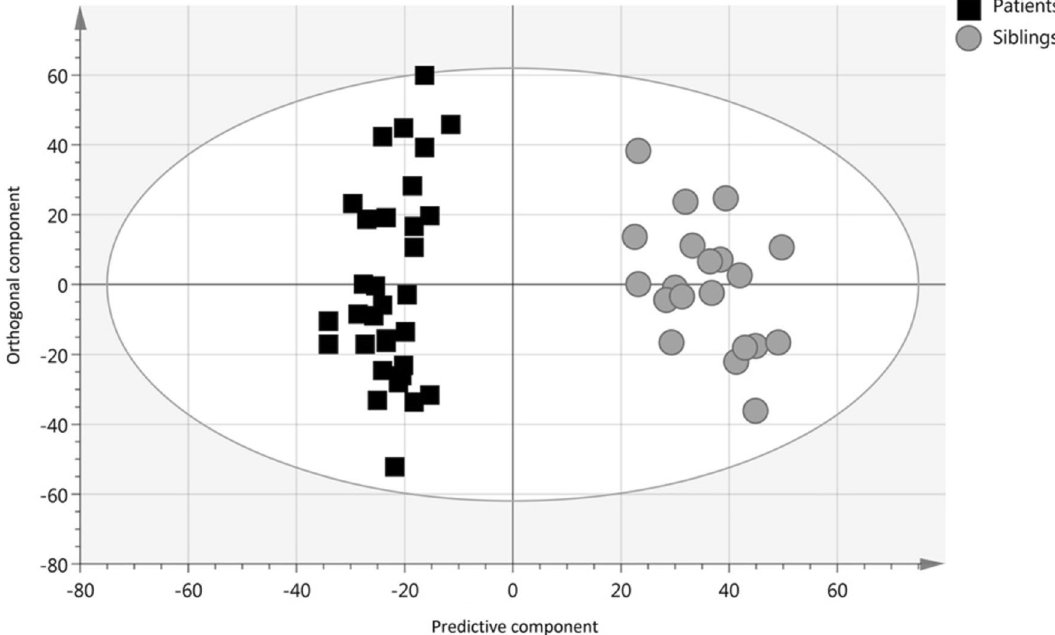
Figure 2. Fecal metabolome OPLS-DA scatter plot of HD patients (n = 34) vs. healthy siblings (n = 21). The validity of the OPLS-DA model was confirmed (R 2 Y(cum) = 0.784, Q 2 (cum) = 0.505, CV-ANOVA p-value = 2.83e −06 and good permutation testing).